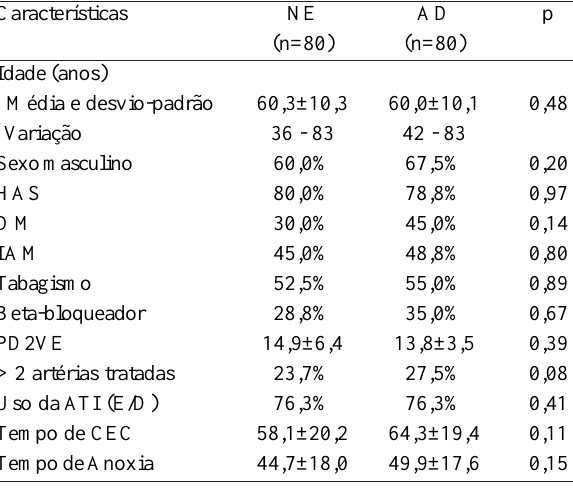
Tabela 2. Distribuição dos episódios de fibrilação atrial segundo os grupos estudados.